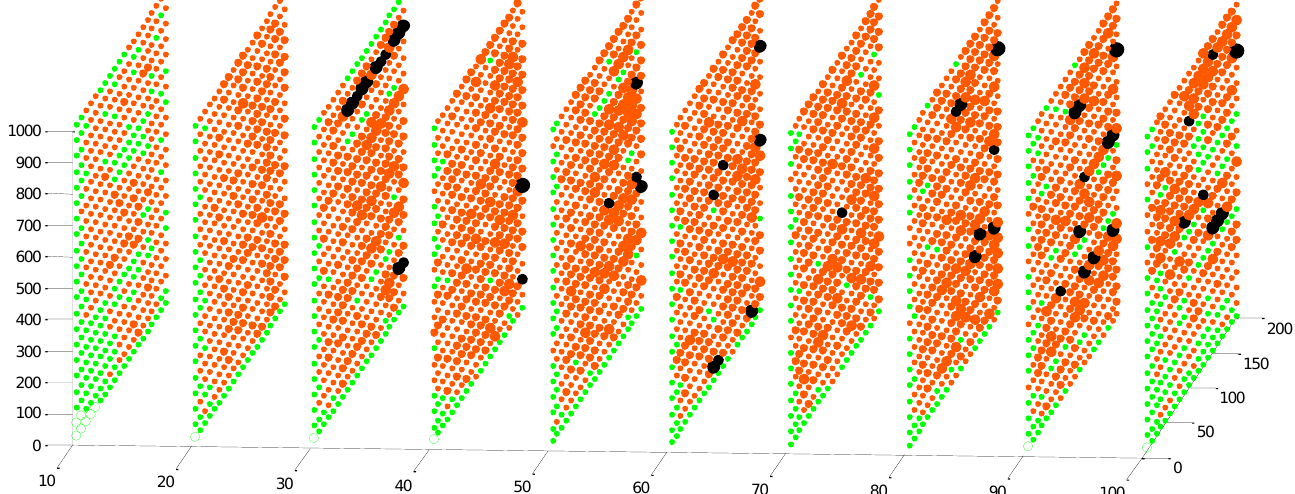
c on CIFAR-10 images. It is slightly better than Fig. 6. Performance 36